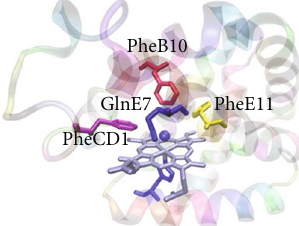
Figure 1: Tertiary structure and the heme active site of the HbI from Lucina pectinata (PDB:1MOH). The active site shows the amino acid around the heme